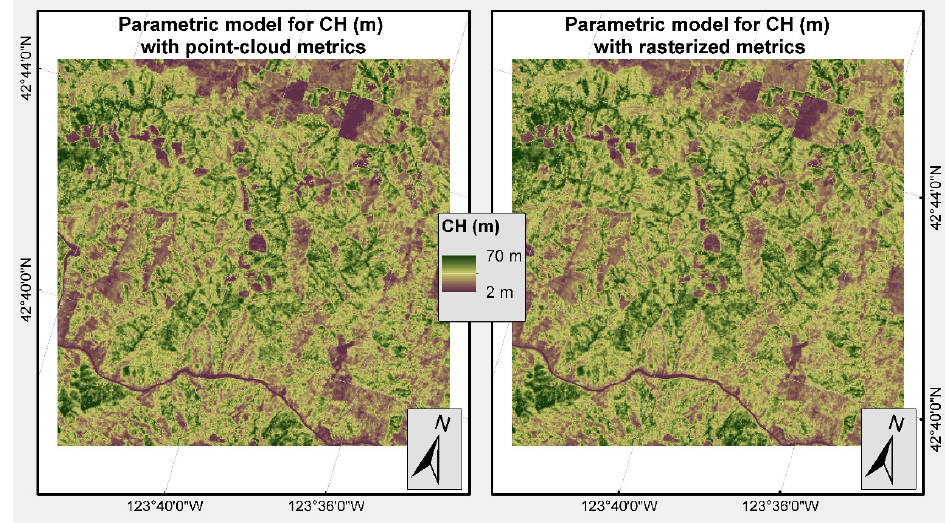
Figure A7. Maps of canopy height, CH, for a section of the ALS acquisition 5 Rogue Valley. The left map was derived with the parametric model using point-cloud predictors and the right map was obtained with the parametric model using rasterized predictors. Both maps were obtained using the eight ALS acquisitions described in the Section 2.1.